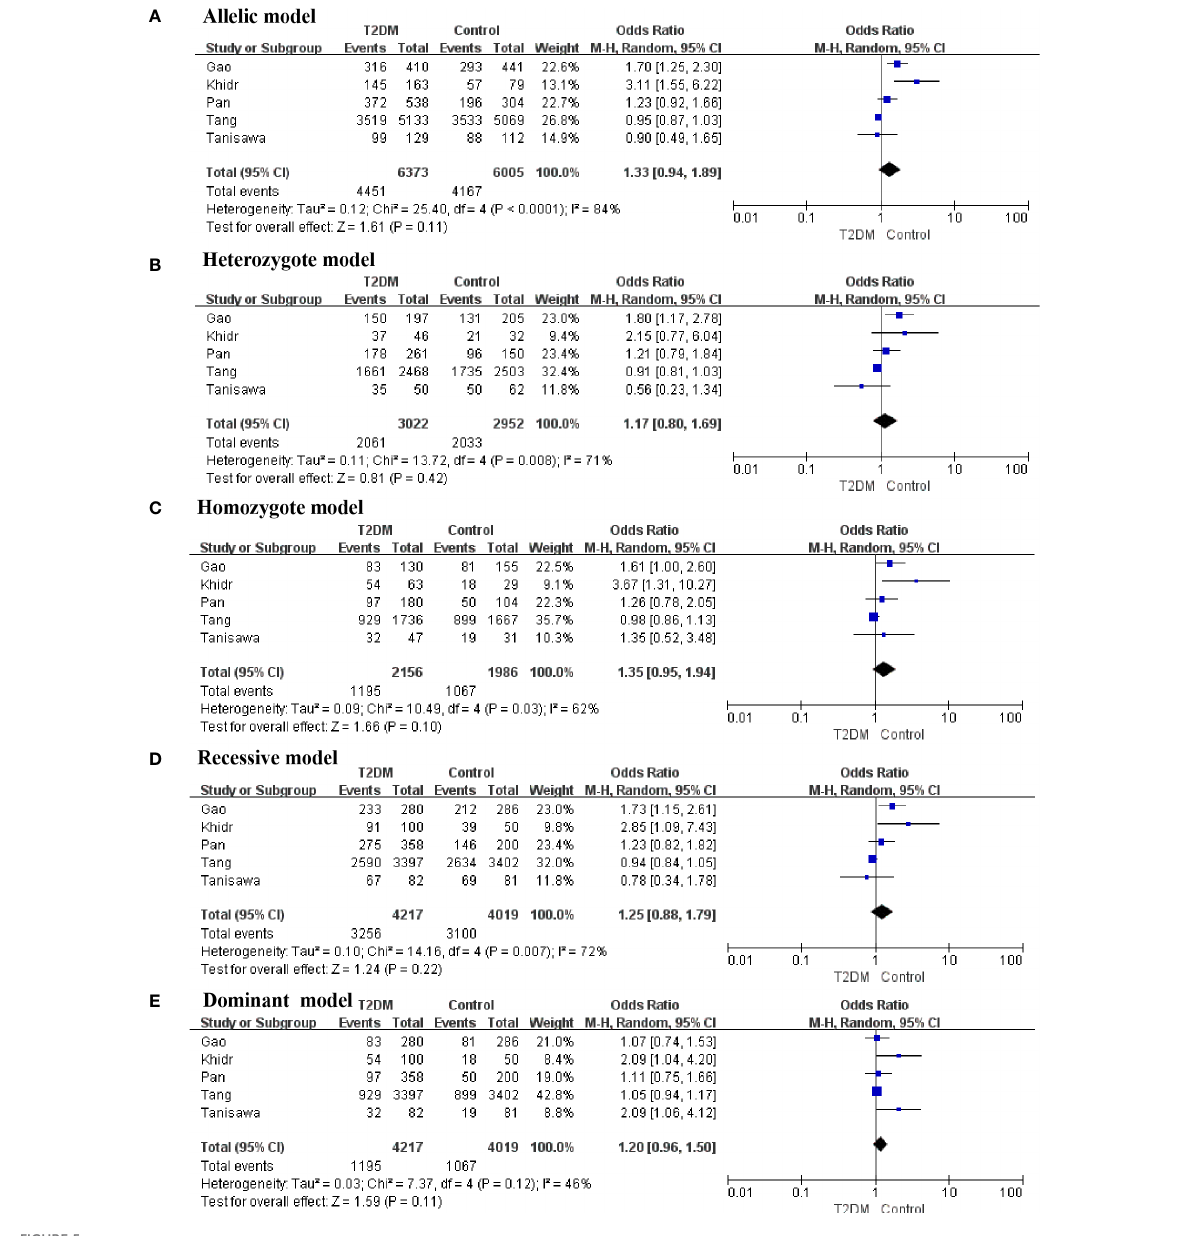
FIGURE 5 Forest plots of the polymorphism of rs16835198 and the T2DM risk under fi ve genetic models. (A) allelic, (B) heterozygote, (C) homozygote, (D) recessive, and (E) dominant genetic